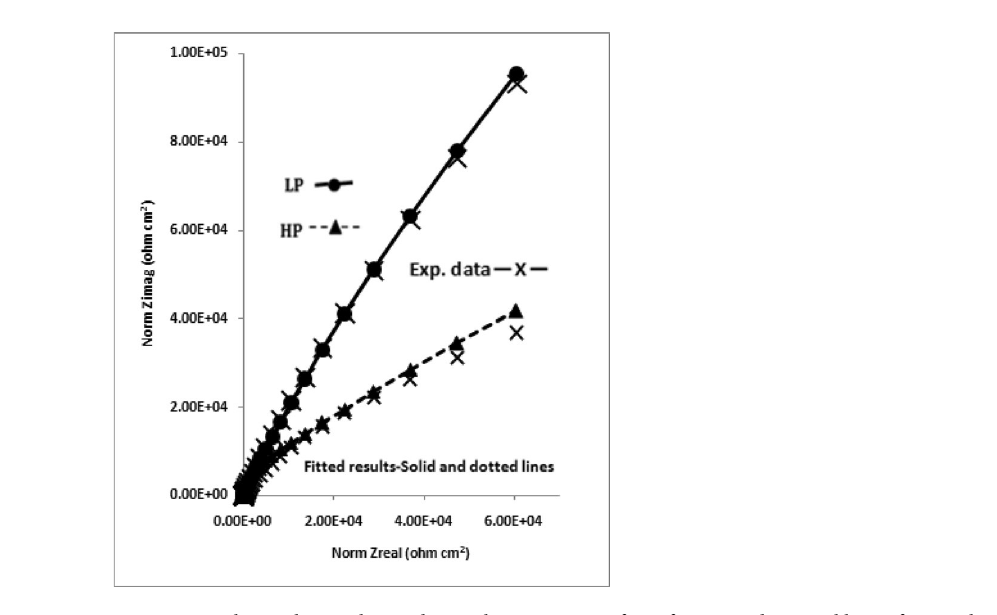
Figure 15. Electrochemical impedance plots in Nyquist form for HP and LP steel bars after 192 h of their exposure in chloride free